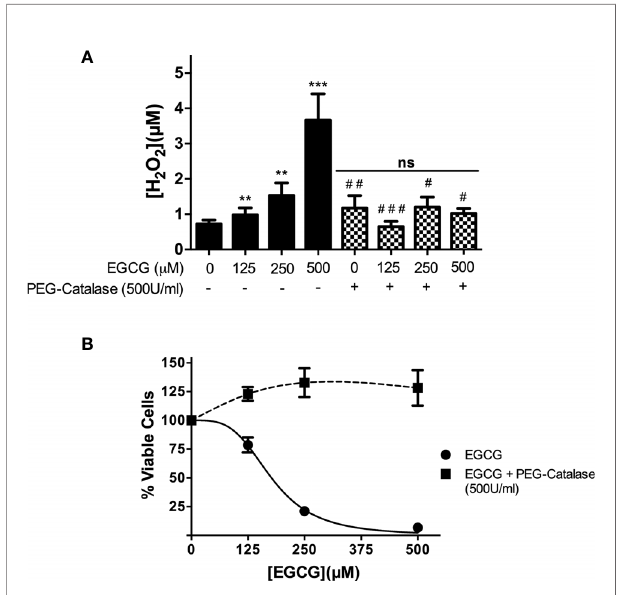
FIGURE 3 | EGCG induces a boost of H 2 O 2 in L. infantum promastigotes that leads to parasite death. Promastigotes of L. infantum were cultivated in Schneider ’ s Drosophila medium at 26°C for 72 h with EGCG (125 – 500 µM) in the absence or in the presence of PEG-catalase (500 U/ml). H 2 O 2 was measured with Amplex Red and expressed as the H 2 O 2 concentration (A) . Cellular viability was measured using the alamar Blue assay (B) . Values represent mean ± standard error of three different experiments. ** indicates a signi fi cant difference relative to the control group (p < 0.01); *** indicates a signi fi cant difference relative to the control group (p < 0.001); # indicates a signi fi cant difference relative to the L. infantum incubated with 500 µM of EGCG (p < 0.05); ## indicates a signi fi cant difference relative to the L. infantum incubated with 500 µM of EGCG (p < 0.01); ### indicates a signi fi cant difference relative to the L. infantum incubated with 500 µM of EGCG (p <